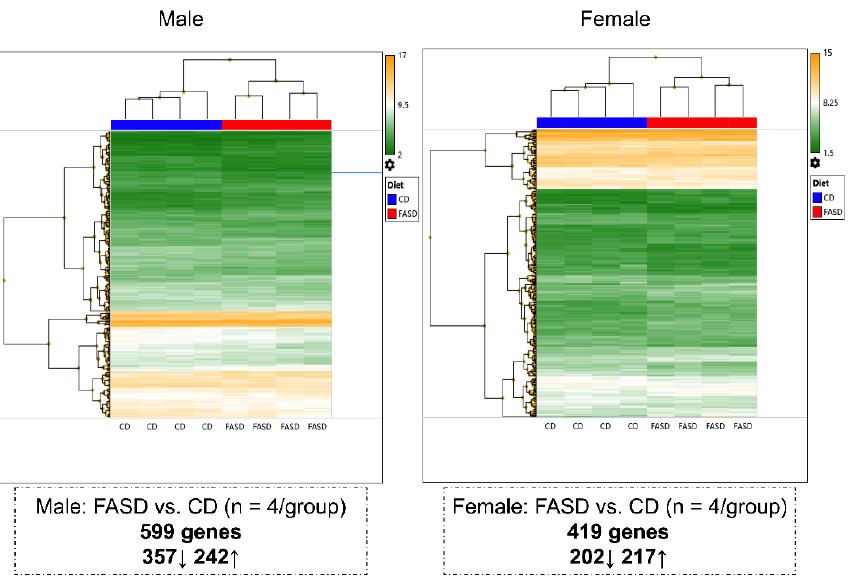
Figure 1. Hierarchical clustering showing different changes in P30 cortical gene expression due to maternal FASD in males and females. A total of 599 genes (357 downregulated, 242 upregulated) were differentially expressed in FASD males compared with CD males, and 419 genes (202 downregulated, 217 upregulated) were differentially expressed in FASD females compared with CD females.